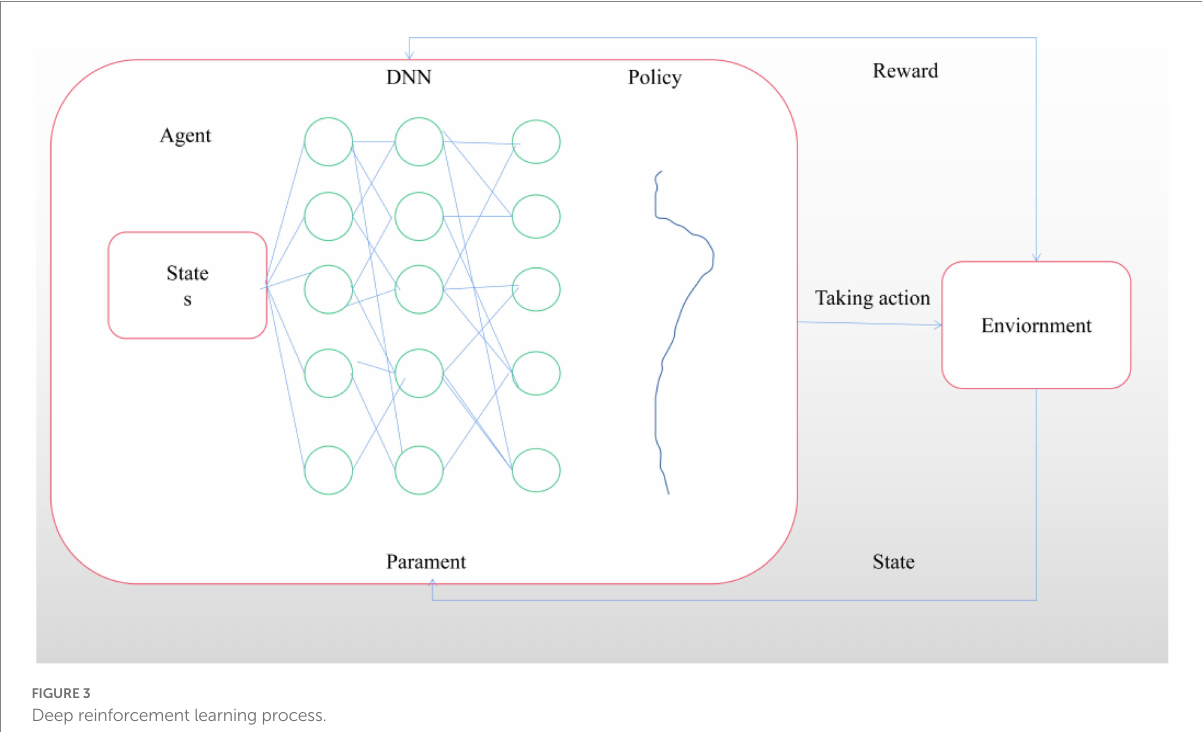
FIGURE 3 Deep reinforcement learning